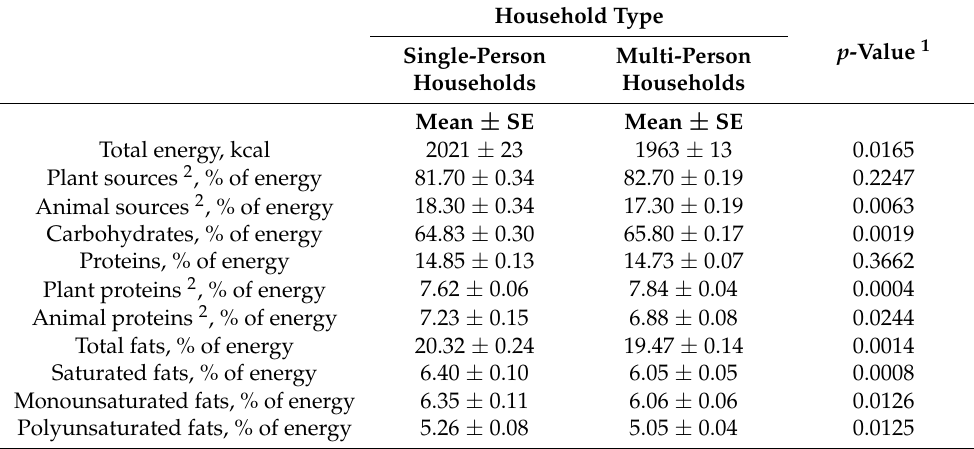
Table 2. Energy and macronutrient intake of Korean adults according to household type, KNHANES 2014–2018.